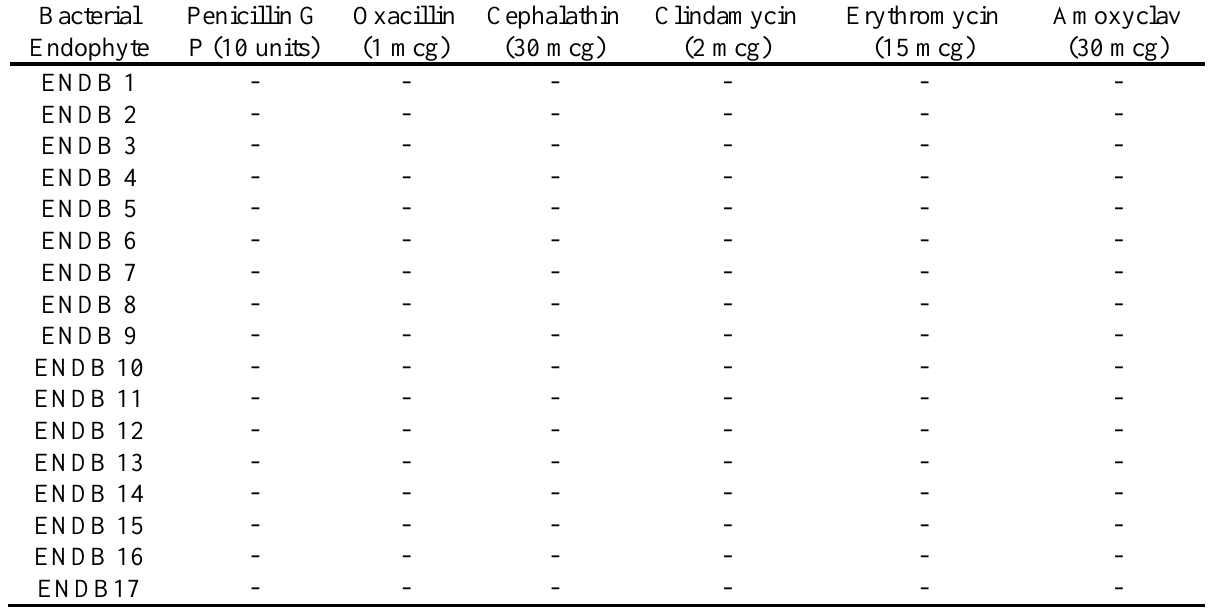
Table 2. Antibiogram of bacterial endophytes against six standard